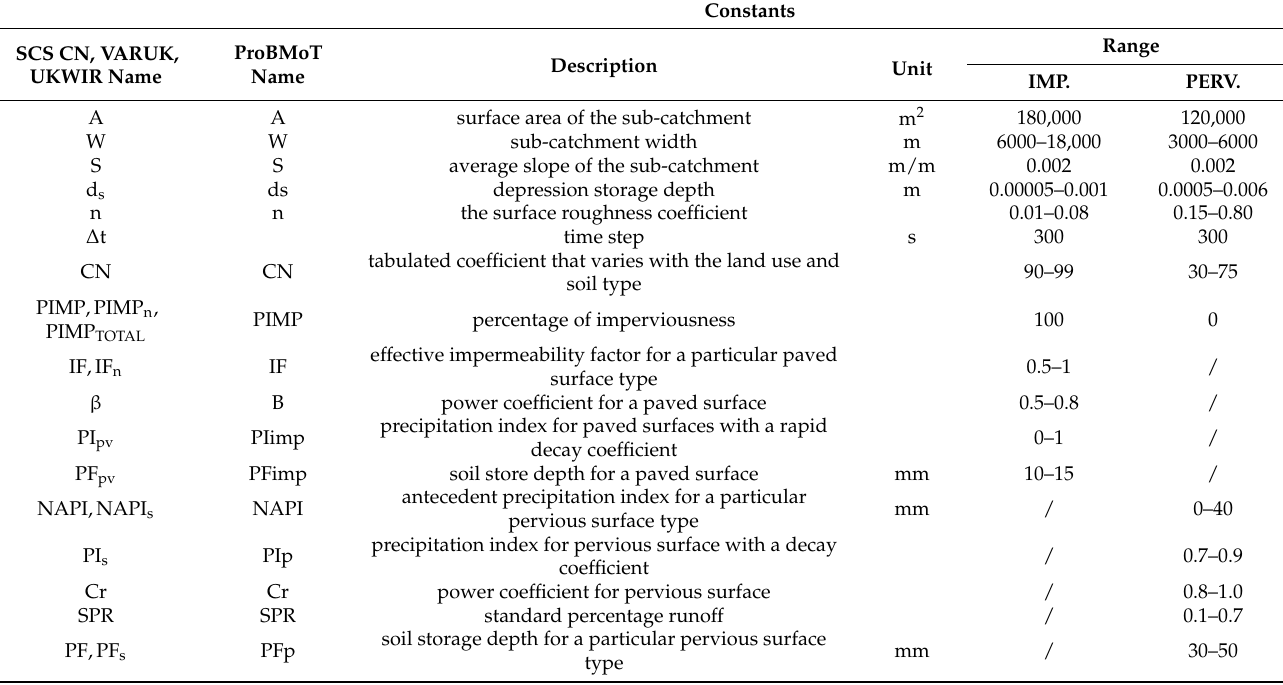
Table 3. Description of constants included in the rainfall-runoff model, with assigned ranges for impervious and pervious areas (entity